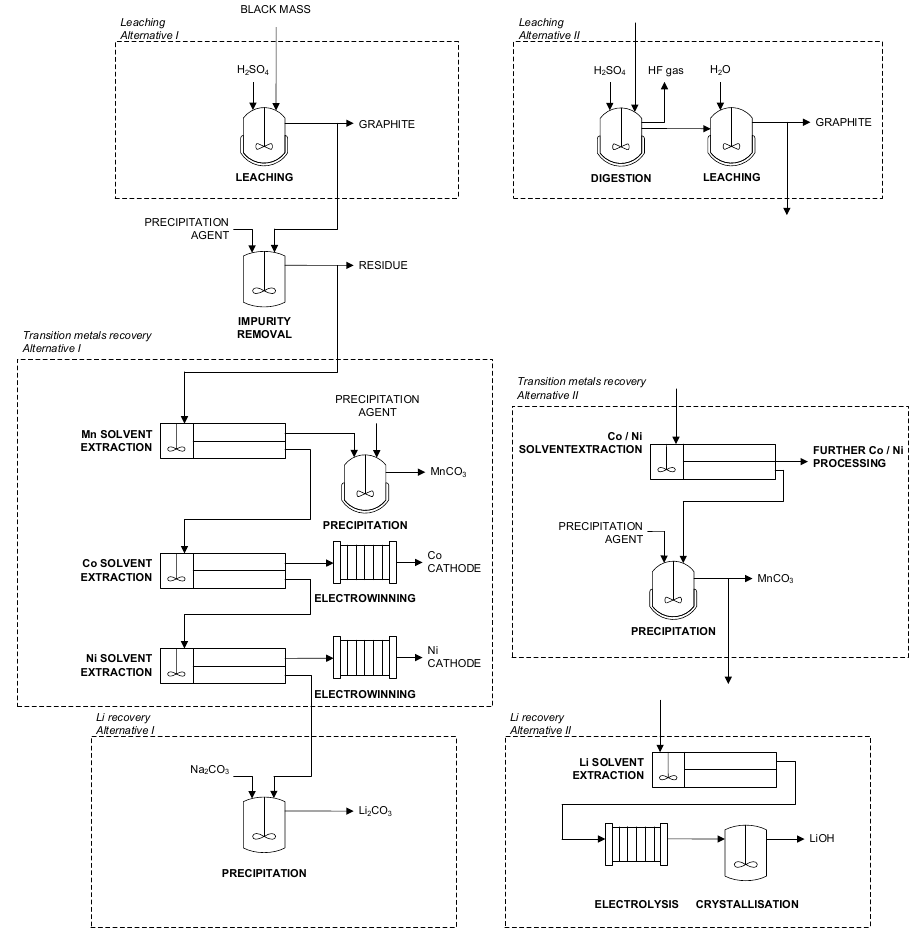
Figure 10. Simplified flowsheet of the process at JX Nippon Mining & Metals Corporation (left) based on [66] and process alternatives for leaching, transition metal recovery, and Li recovery (right) based on [83,84].